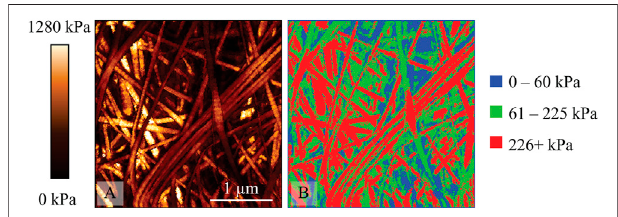
FIGURE 5 | A cross-linked collagen sample prepared from 2 mg/ml solution (A) 3 μ m × 3 μ m effective modulus map from QI data with fi xed range